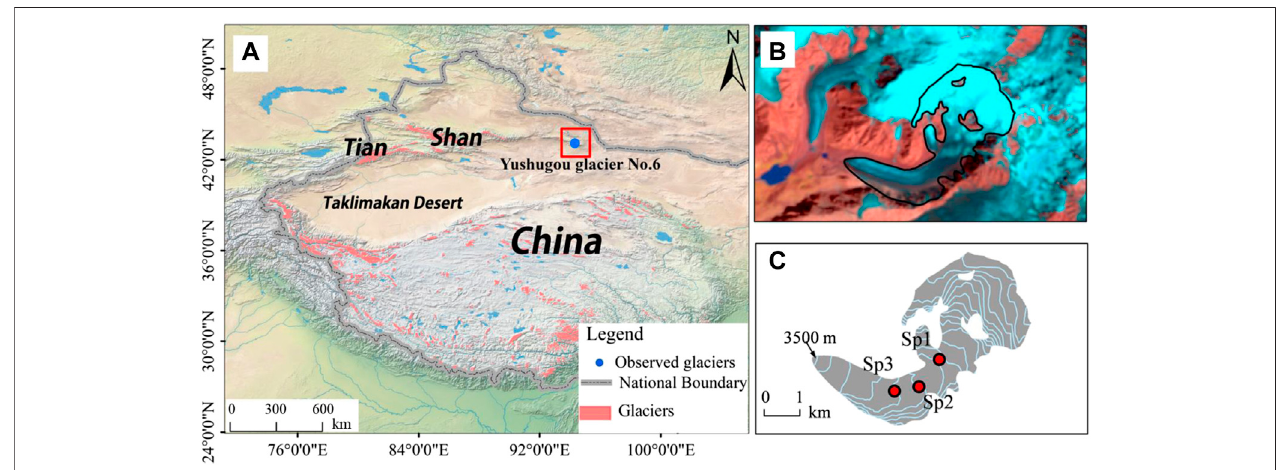
FIGURE1| RegionalsettingofYushugouGlacierNo.6: (A) locationinChina; (B) satelliteimagewiththeglacieroutlined; (C) topographicmapoftheglacierandthe sampling sites in 2017 and in 2018, contour interval (cid:2) 100 m.